Question: Give a one-sentence summary of this figure.
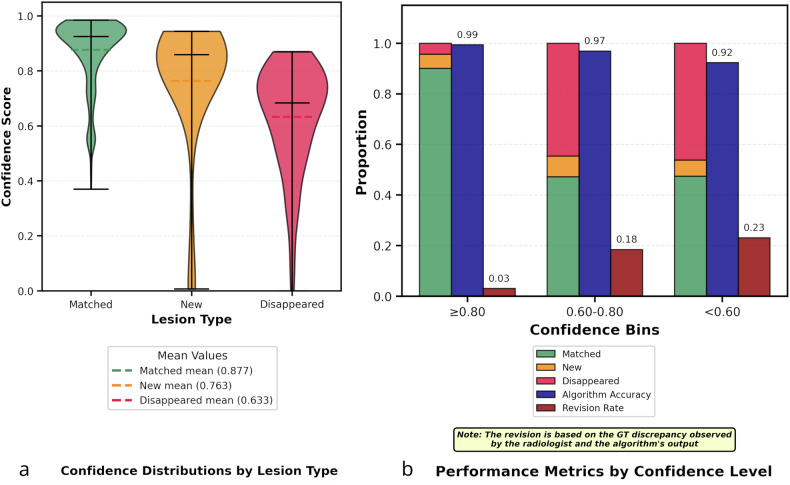
Answer: Confidence distributions and triage utility in high–lesion-count colorectal liver metastases. a Confidence score distributions by lesion class (matched, new, disappeared) in the high–lesion-count subset (> 10 lesions/scan). b Performance stratified by confidence bins